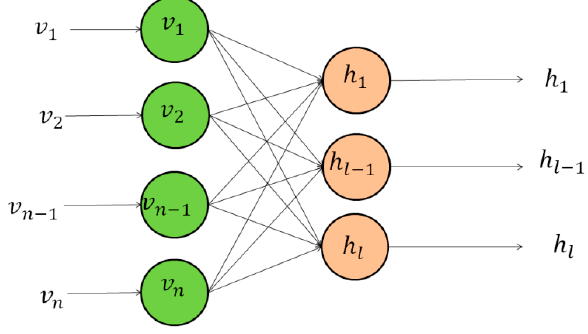
Figure 6. Restricted Boltzmann machine.